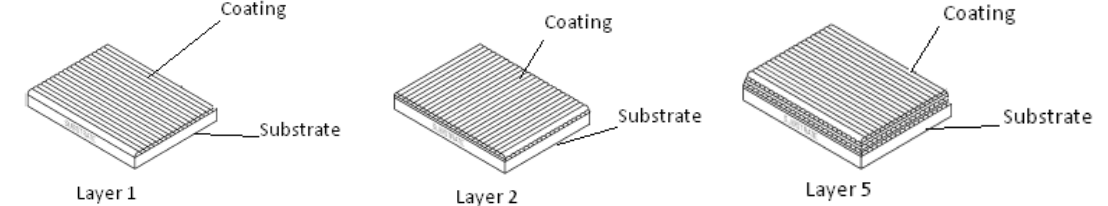
Figure 1: Schematic representation of powder-coated products